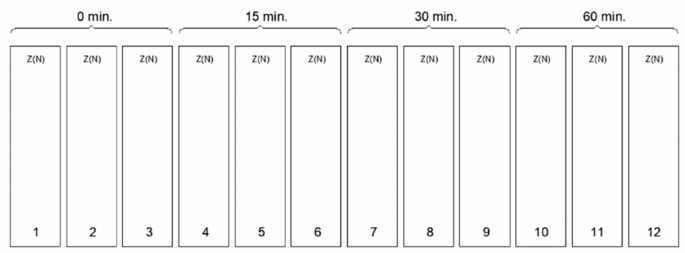
Figure 2. Samples arranged after high-temperature